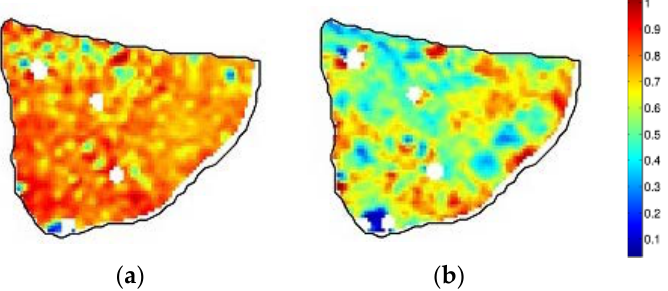
Figure 5. Sum average of band 8 (b8_avg) for a sample parcel. Dates are: ( a ) 30 May 2014; ( b ) 1 November 2014.